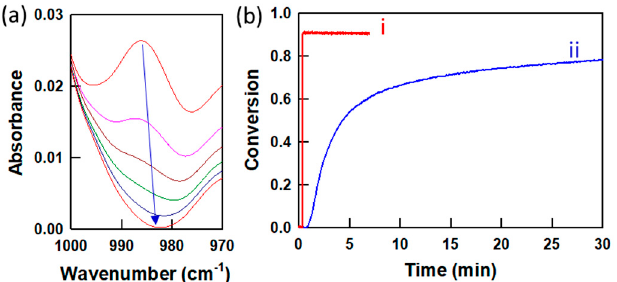
Figure 3. Acrylate conversion at ( a ) 980 cm − 1 from real-time FTIR examination irradiated with 200 mW cm − 2 UV light for the LC mixtures formulated with 1 wt% Irgacure 369, 10 wt% C6M, 5 wt% R1011 and 84 wt% E7, and ( b ) summary of acrylate conversion at 980 cm − 1 of the LC mixtures (i) with and (ii) without 1 wt% Irgacure 369 exposed with 200 mW cm − 2 UV light for 30 min.